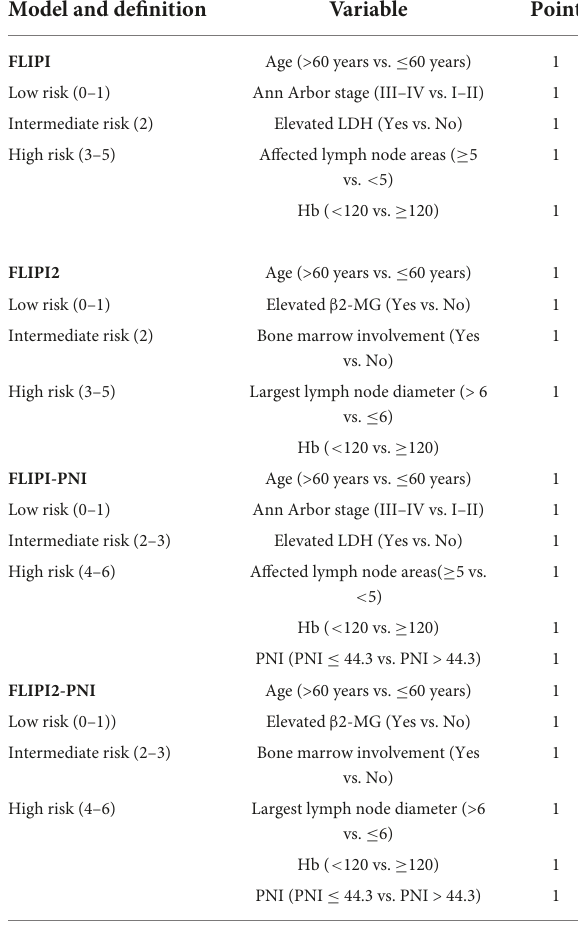
TABLE 5 Variables and definitions of different